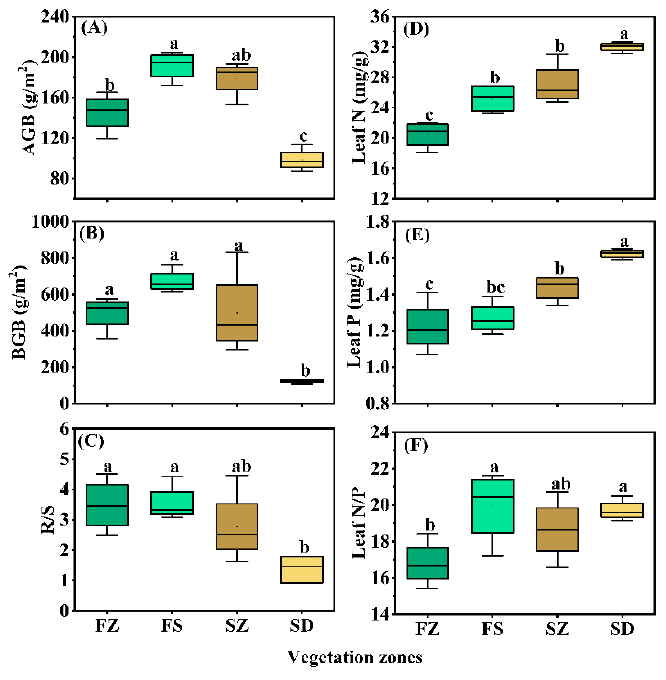
Figure 4. Boxplots of leaf N, P stoichiometry and plant biomass in each of vegetation zones along latitudinal gradients. Note: ( A ), AGB: above-ground biomass; ( B ), BGB: below-ground biomass; ( C ), R/S: root-to-shoot ratio; ( C , F ), FZ: forest zone; FS: forest–steppe zone; SZ: steppe zone; SD: steppe–desert zone. ( D ), Leaf N: leaf N content; ( E ), Leaf P: leaf P content. The boundaries of the box represent the lower (25%) and upper (75%) quartiles of data, respectively, and the median is represented by the line inside the box. Different lowercase letters above the bars indicate significant differences (ANOVA, p < 0.05) among different vegetation zones.